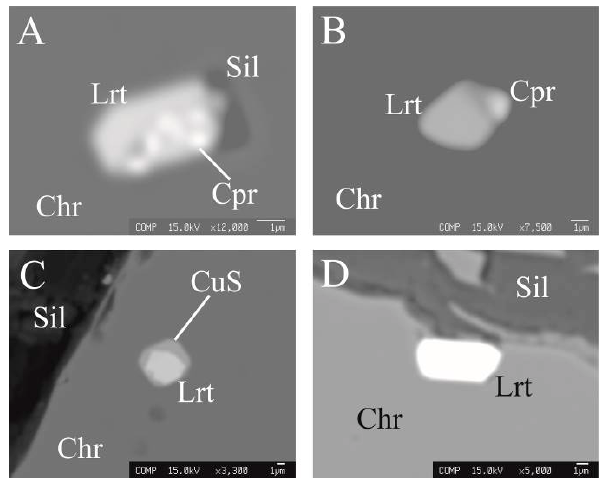
Figure 7. Back-scattered electron (BSE) images of magmatic PGM associated with the chromitites of Kurmanovskoe, from Alapaevsk ophiolite. ( A,B ) Crystals composed of laurite and cuproiridsite included in fresh chromite; ( C ) laurite associated with a Cu-sulfide, included in fresh chromite; ( D ) single phase laurite in crack. Abbreviations: Chr = chromite; Lrt = laurite; Cpr = cuproiridsite, Sil = silicates; CuS = Cu-sulfide.